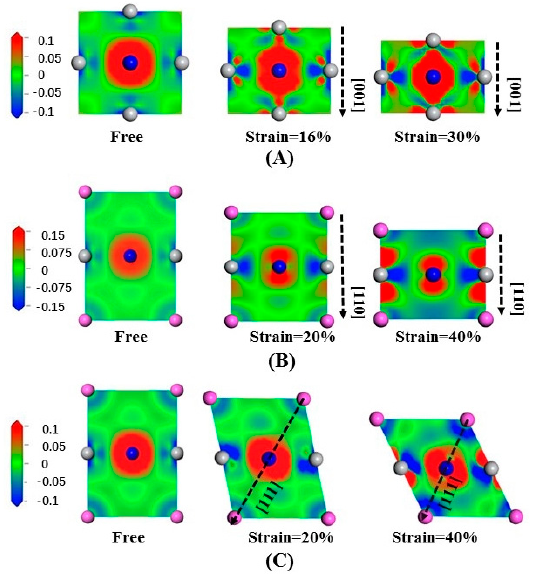
Figure 8. Electron density difference of Ti 3 AlN: ( A ) compressed along [001] in the slice of (200); ( B ) compressed along [110] in the slice of (1 1(cid:3364) 0); ( C ) compressed along [111] in the slice of (1 1(cid:3364) 0).